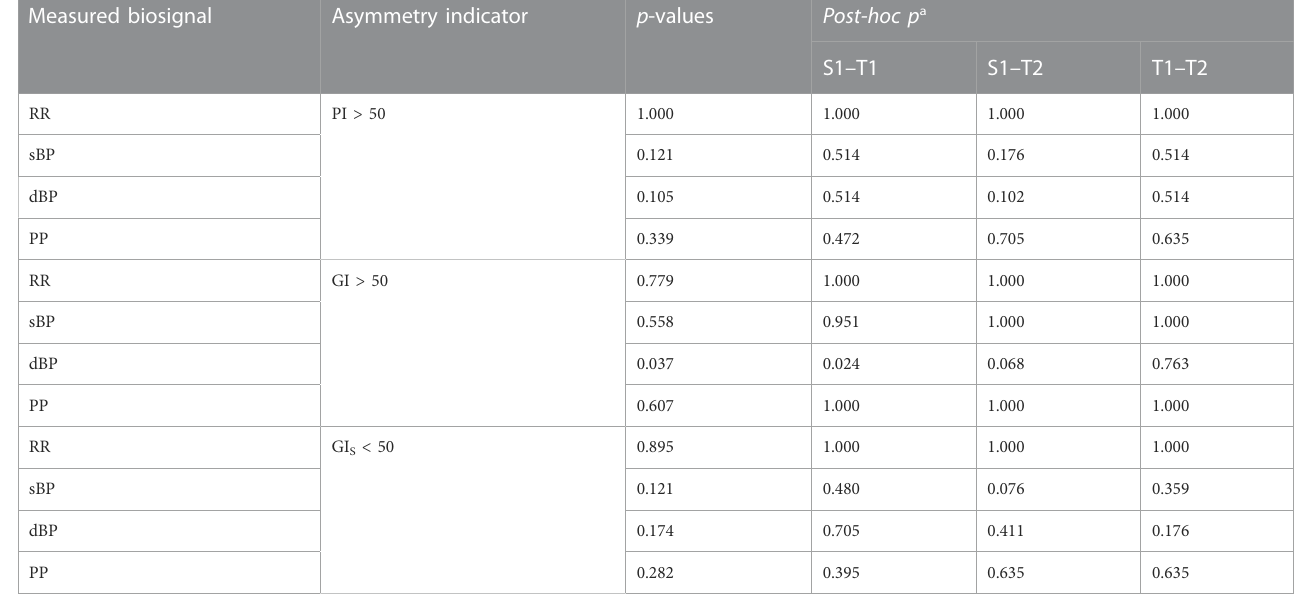
TABLE5Asymmetryproportioncomparisonsintheanalyzedbiosignals:theasymmetryoccurrencebetweensupine(S1),theinitialpartoftilt(T1),andthepre-syncope phase of tilt (T2) in the head-up tilt test in vasovagal patients obtained by Porta ’ s Index (PI > 50) and Guzik ’ s Index (GI > 50 and GI S < 50).